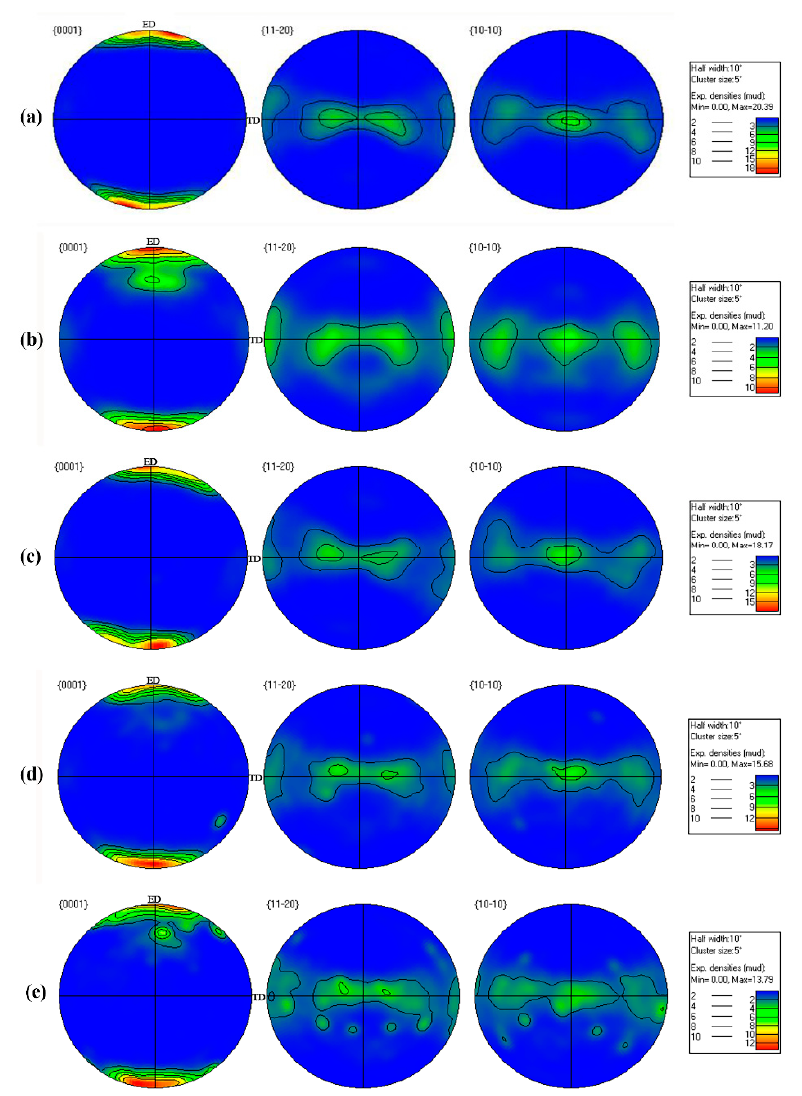
Figure 9. Pole figure for different temperatures at a strain rate of 1 × 10 − 2 s − 1 : ( a ) 300 °C; ( b ) 350 °C; ( c ) 400 °C; ( d ) 450 °C; ( e ) 500 °C.